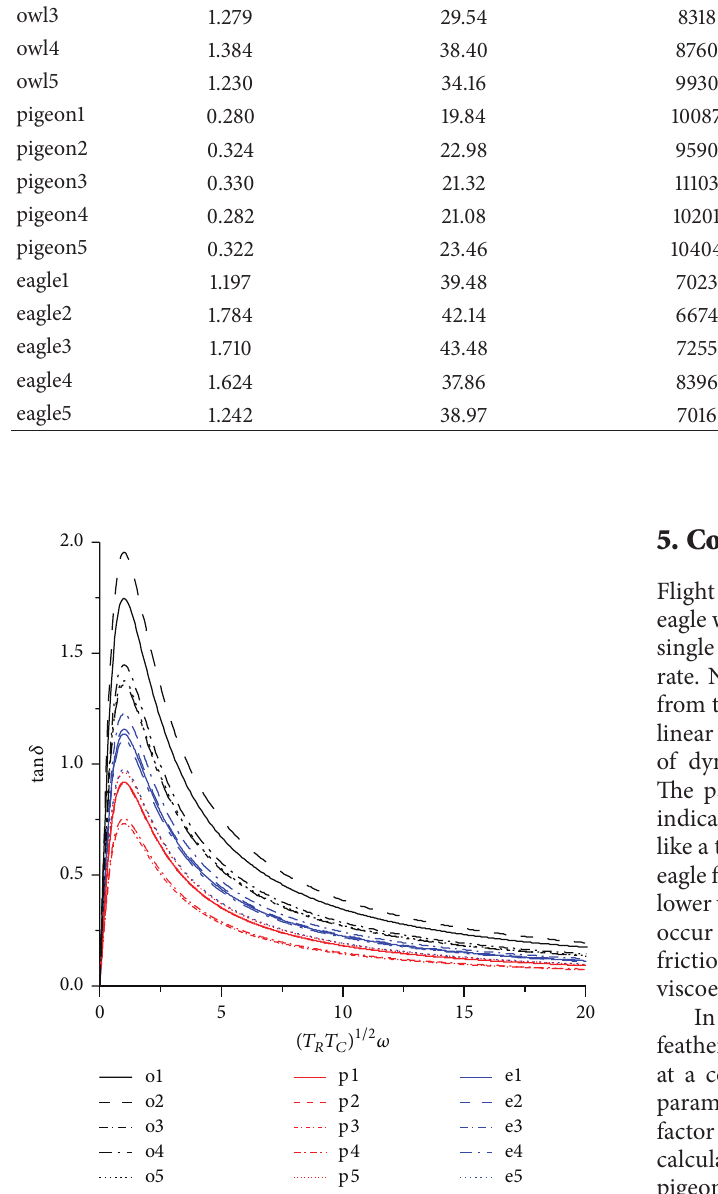
Figure 6: Internal friction spectrum of feather shaft specimens.